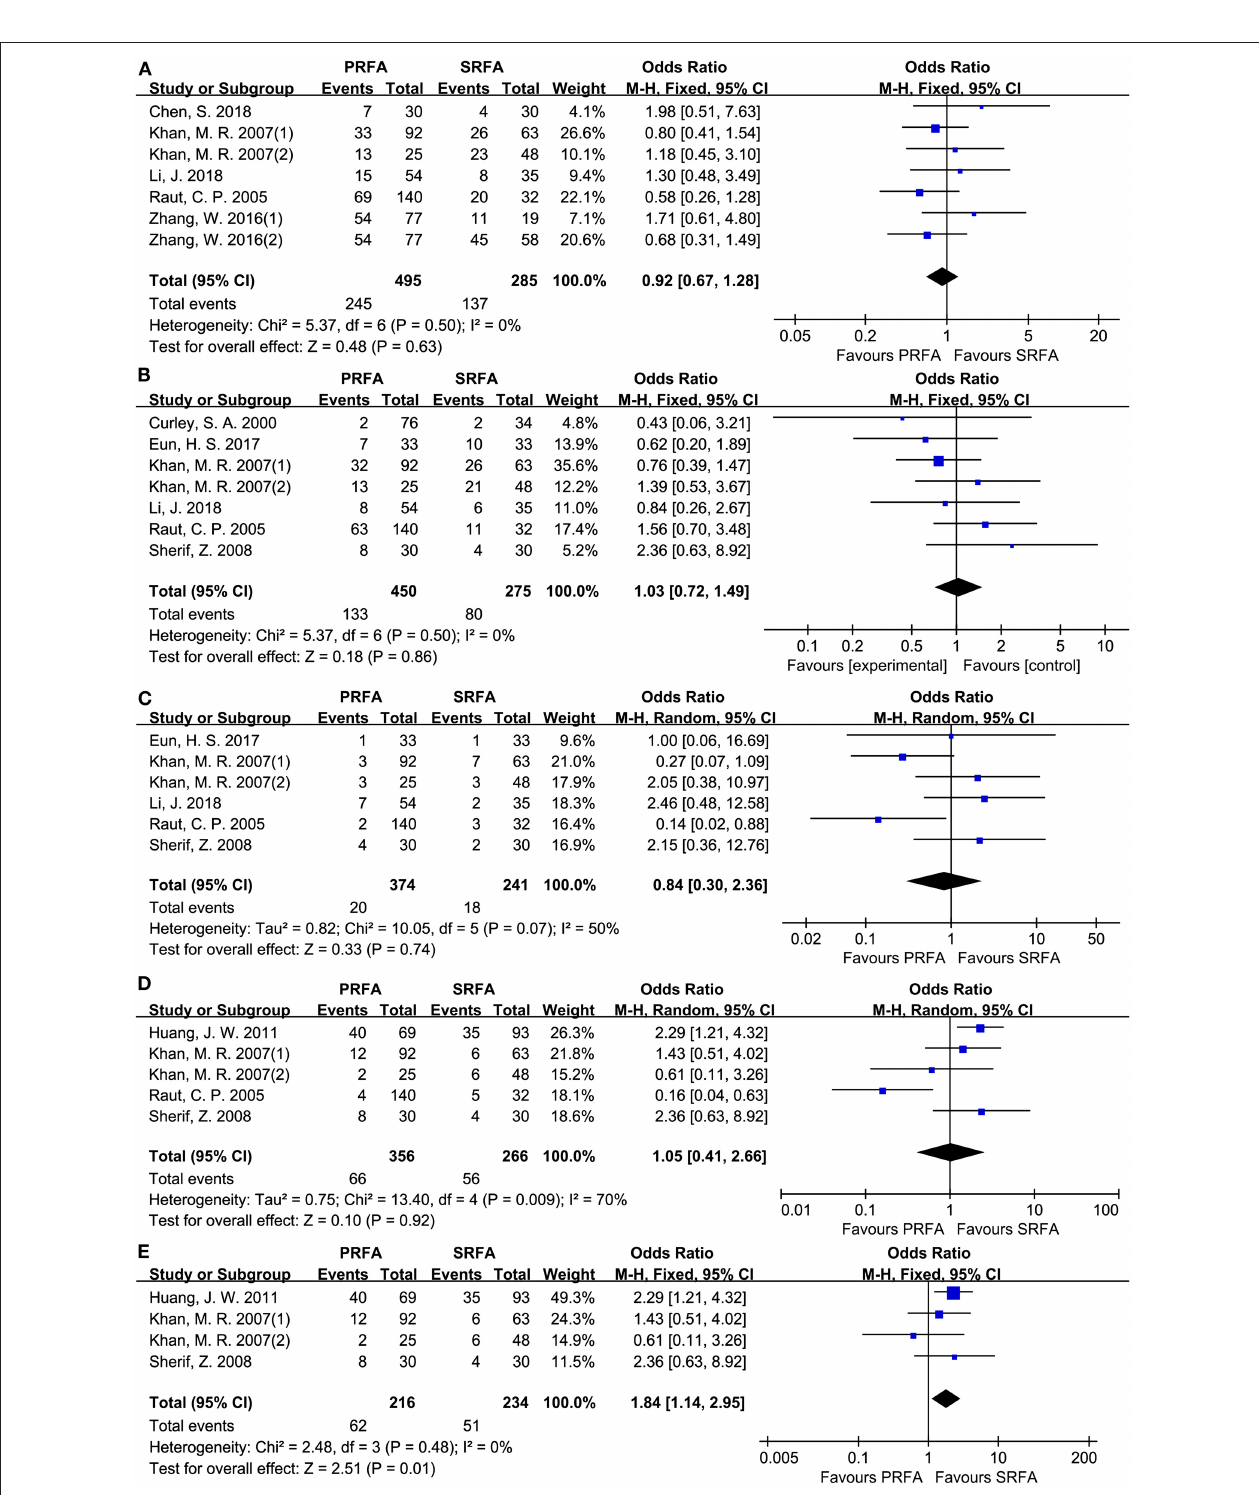
FIGURE 3 | Forest plot for tumor recurrence. (A) Forest plot for total recurrence indicates no significantly between the PRFA group and the SRFA group (49.49% and 48.07%, respectively; OR, 0.92; 95% CI, 0.67-1.28; p = 0.63). (B) Forest plot for intrahepatic recurrence indicates no significantly between PRFA and SRFA (29.56% and 29.09%, respectively; OR, 1.03; 95% CI, 0.72-1.49; p = 0.86). (C) Forest plot for extrahepatic metastasis indicates no significantly between PRFA and SRFA (5.35% and 7.47%, respectively; OR, 0.84; 95% CI, 0.30-2.36; p = 0.61). (D) Forest plot for local recurrence indicates no significantly between PRFA and SRFA (18.54% and 21.05%, respectively; OR, 1.05; 95% CI, 0.41-2.66; p = 0.92; χ 2 = 13.4; p = 0.009, I 2 = 70%). (E) Forest plot for sensitivity analysis of local recurrence indicates less recurrent in the SRFA group (28.7% and 21.79%, respectively; OR, 1.84; 95% CI, 1.14-2.95; p = 0.01; χ 2 = 2.48; p = 0.48, I 2 = 0%).